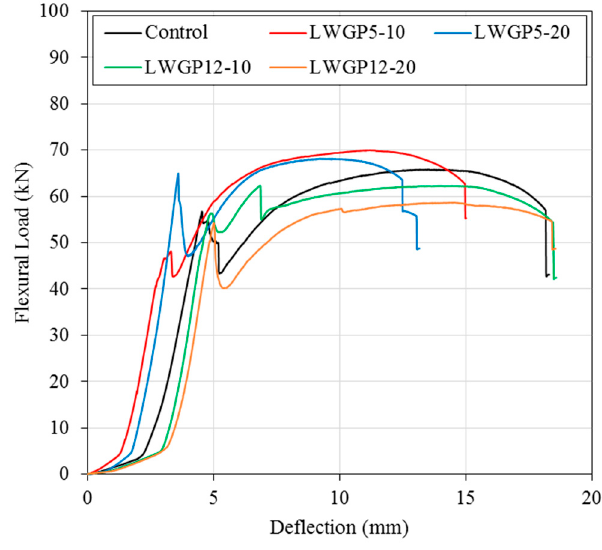
Figure 10. Relationships of the LWGP concrete flume between the crack widths and the loads.